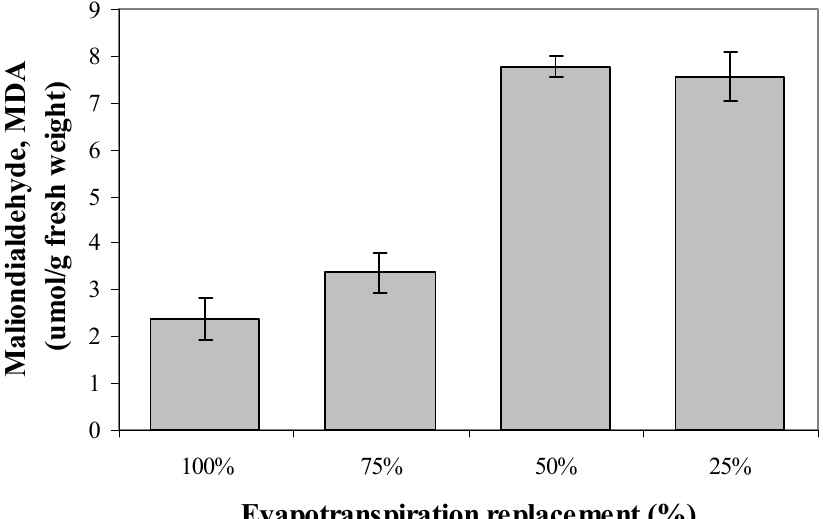
Figure 3. The effects of different evapotranspiration replacement on lipid peroxidation activity of L.pumila . N = 60. Bars represent standard error of differences between means